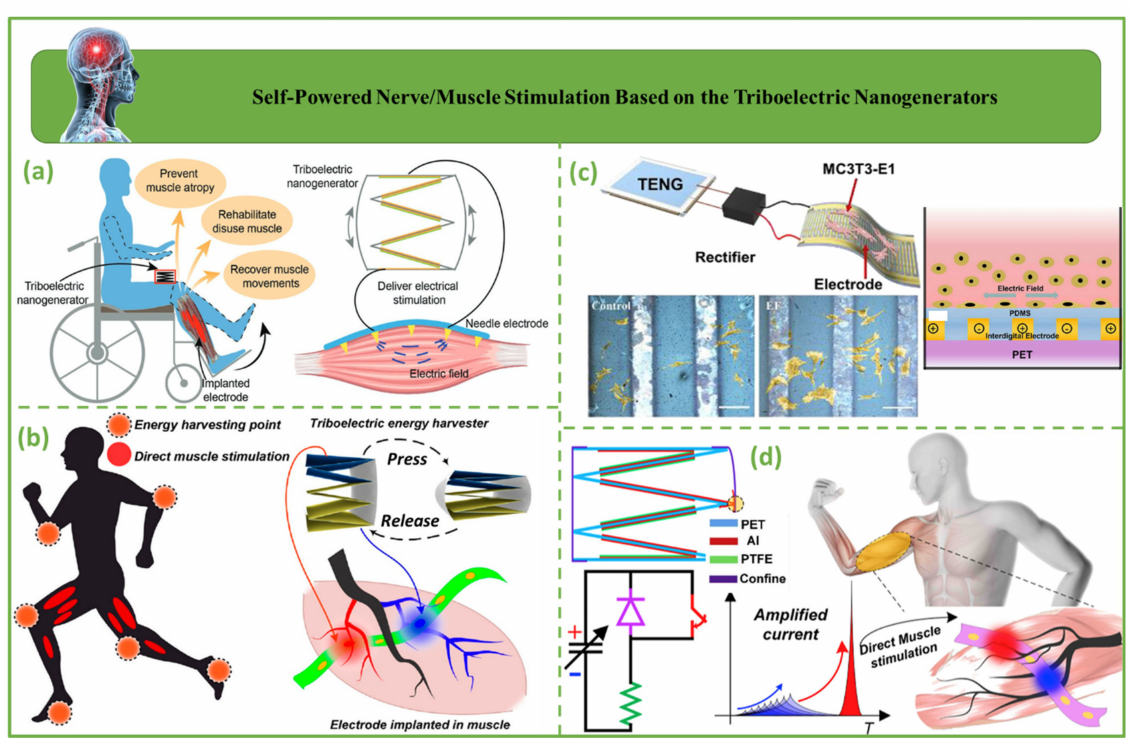
Figure 12. Self-powered nerve/muscle stimulation based on triboelectric nanogenerators. ( a ) Diagram- matic representation of electrical muscle activation directly driven by a TENG [133]. ( b ) Diagrammatic representation of electrical muscle stimulation directly driven by a TENG [38]. ( c ) Self-powered im- plantable electrical stimulator [25]. ( d ) D-TENGs are used for the purpose of direct muscle activation